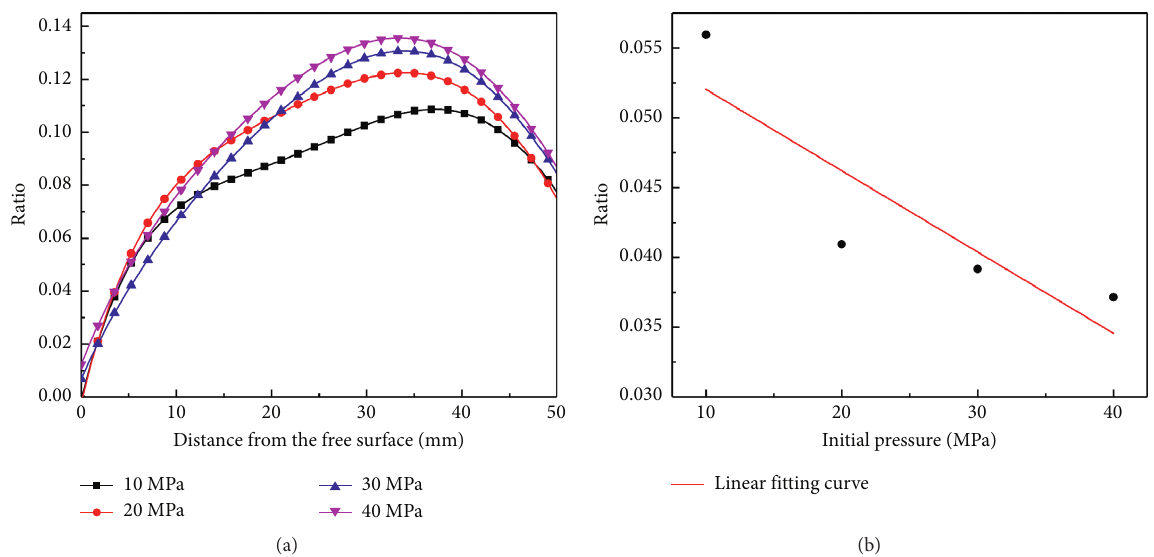
Figure 23: The ratio of shear failure zone at different cross sections and function of the ratio of tensile failure zones of models and in situ